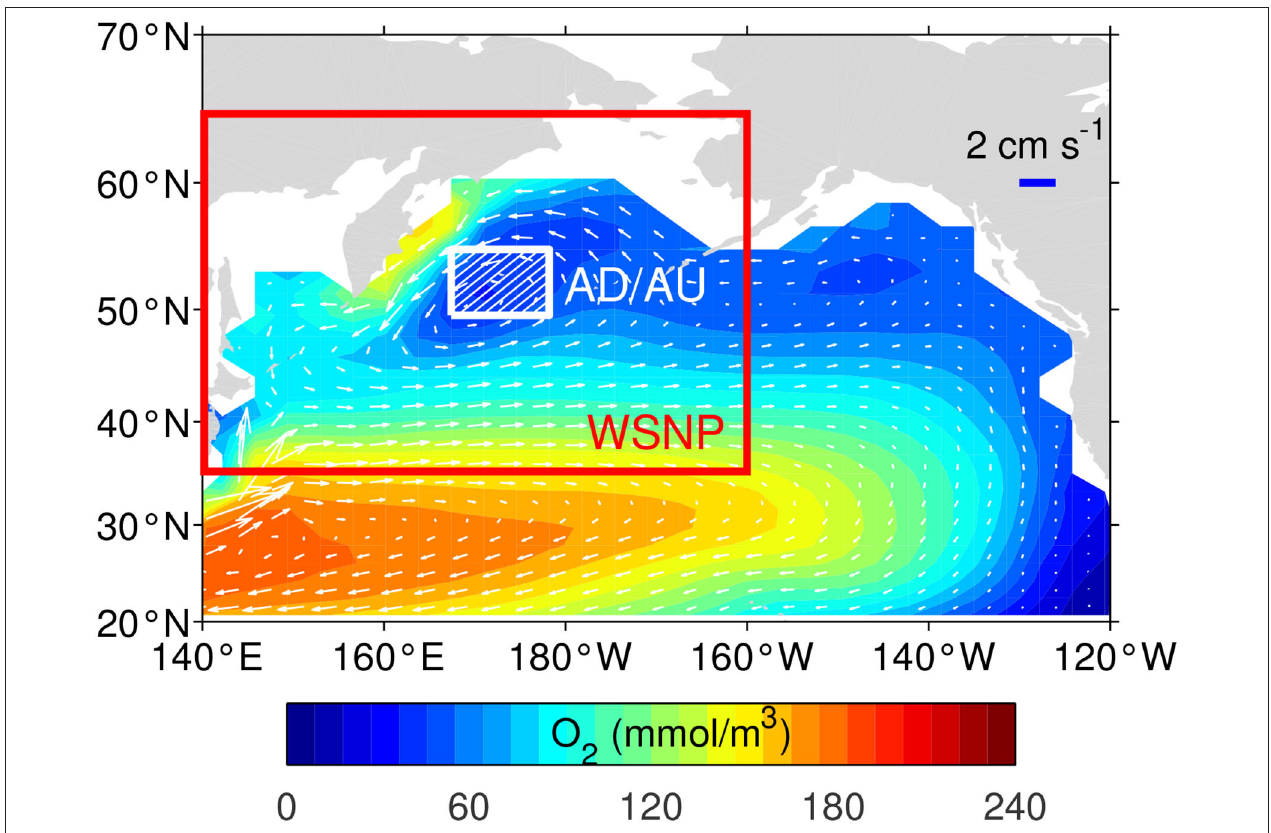
FIGURE 1 | Zoomed in view of the Subarctic North Pacific embedded with year 2020 model-simulated oxygen concentration (color) and velocity vectors (arrows) at a depth of 457.5 m (i.e., model level 5). The red box (140 E–160 W, 30–65 N) defines the Western Subarctic North Pacific (WSNP); the white shadow area (167–179 E, 49–55 N) highlights the location where AD and AU pipes are